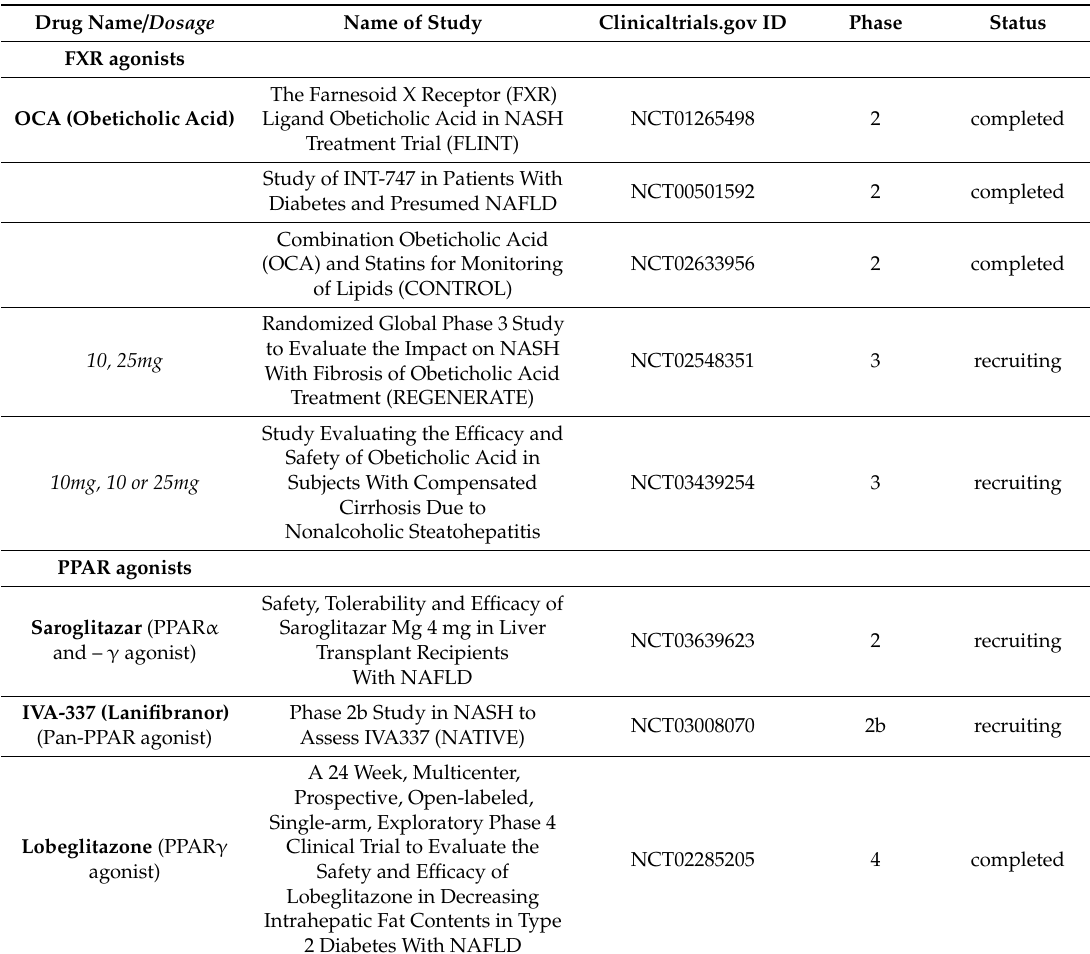
Table 1. Selection of important ongoing studies of farnesoid receptor x (FXR) as well as peroxisome proliferator-activated receptor (PPAR) agonist. Non-alcoholic fatty liver disease (NAFLD), non-alcoholic steatohepatitis